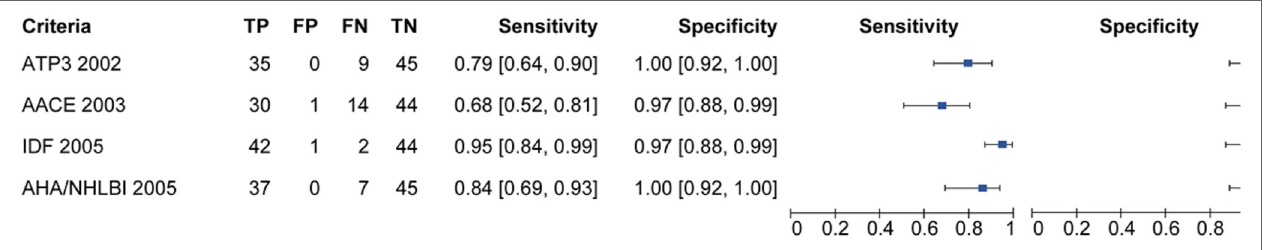
FigUre 2 | Tabulation and graphical plot of sensitivities and specificities.